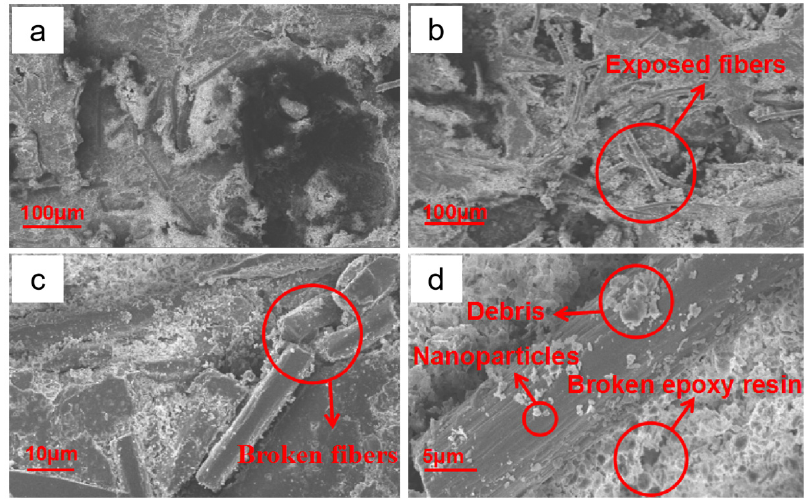
Figure 6. Surface SEM images of the A-CF/EP composites after 60,000 ( a ) and 120,000 ( b – d ) abrasion cycles at different magnifications.